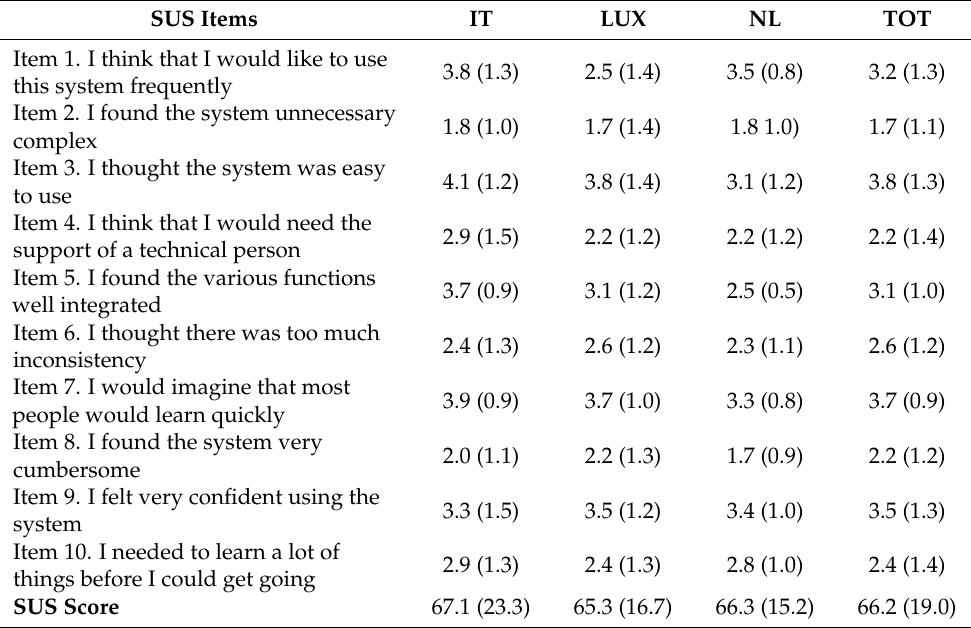
Table 2. System Usability Scale average scores among